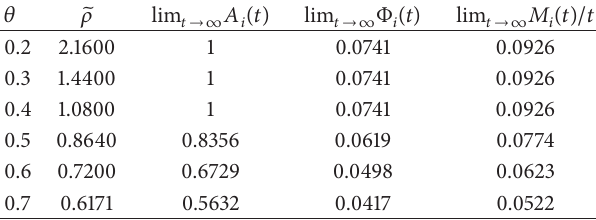
Table 3: The effects of each batch order size parameter 𝜃 on production facility indices (𝜆 = 0.2 , 𝑝 = 0.8 , 𝜇 = 2 , 𝛼 = 0.1 , and 𝛽 = 0.8) .